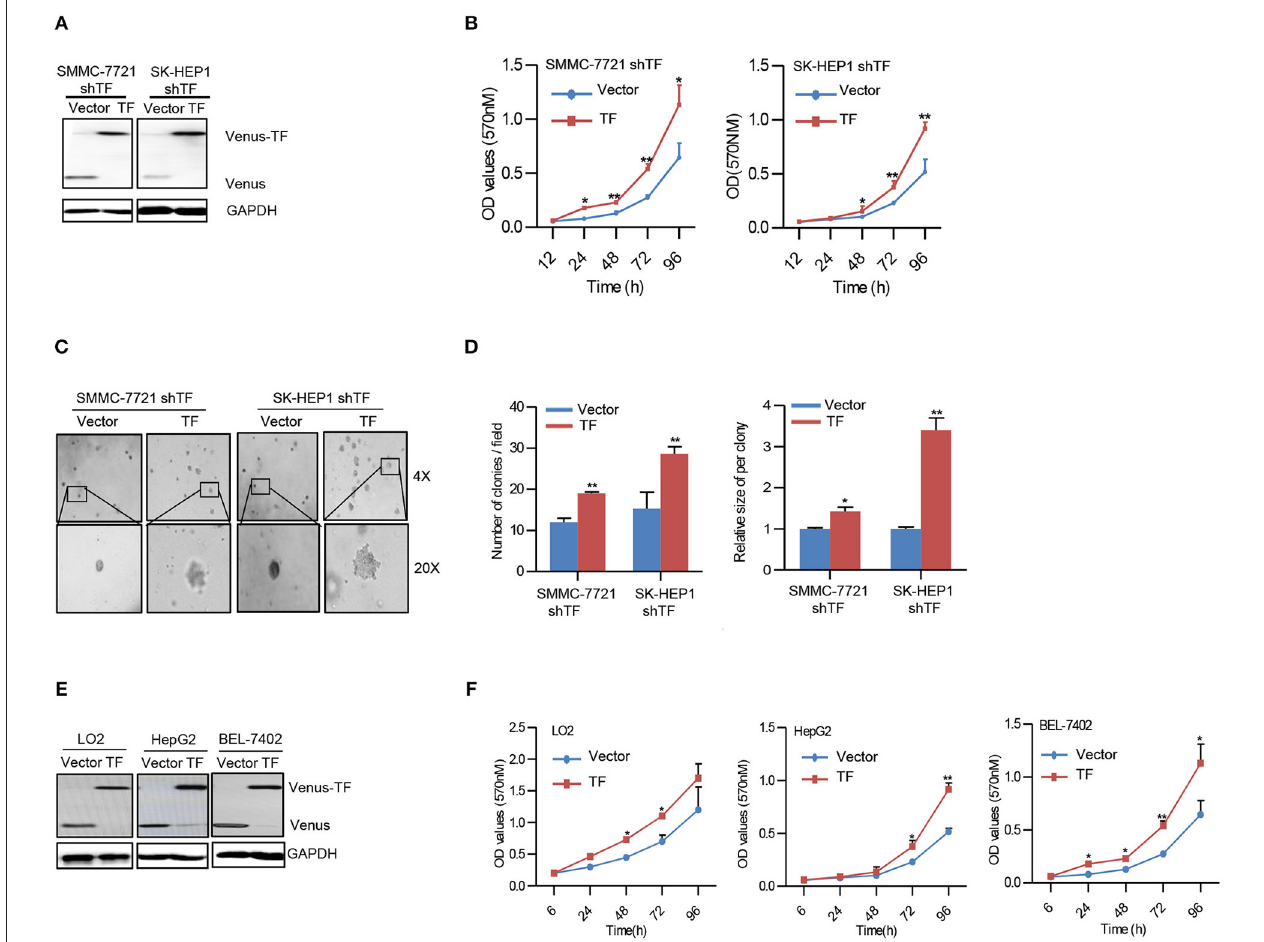
FIGURE 2 | Overexpression of TF promotes the growth of HCC. (A,E) Western blot analysis of the protein expressions in the indicated cells. (B,F) Cell growth of the indicated cells as determined with MTT assay. (C) Representative images and (D) quantification of the indicated cells sphere as determined with sphere formation assay. Error bars, mean ± SD. * p < 0.05 and ** p < 0.01 [two-tailed Student’s t -test (B , D , F) ].